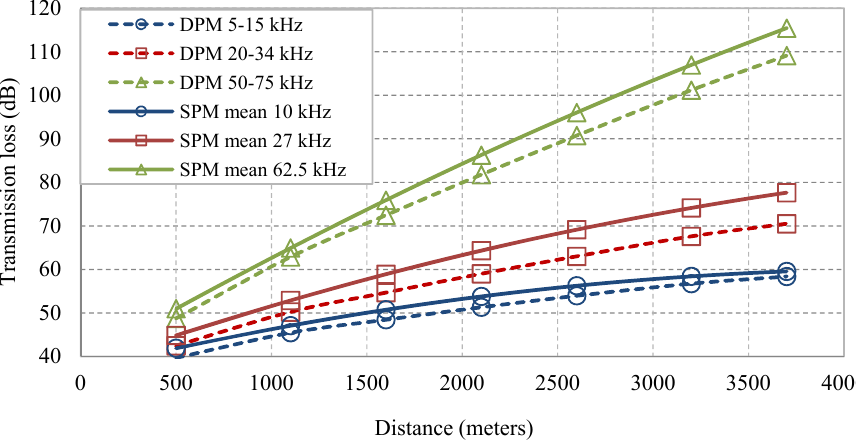
Figure 6. Attenuation of bandwidth signals with DPM and SPM single frequency